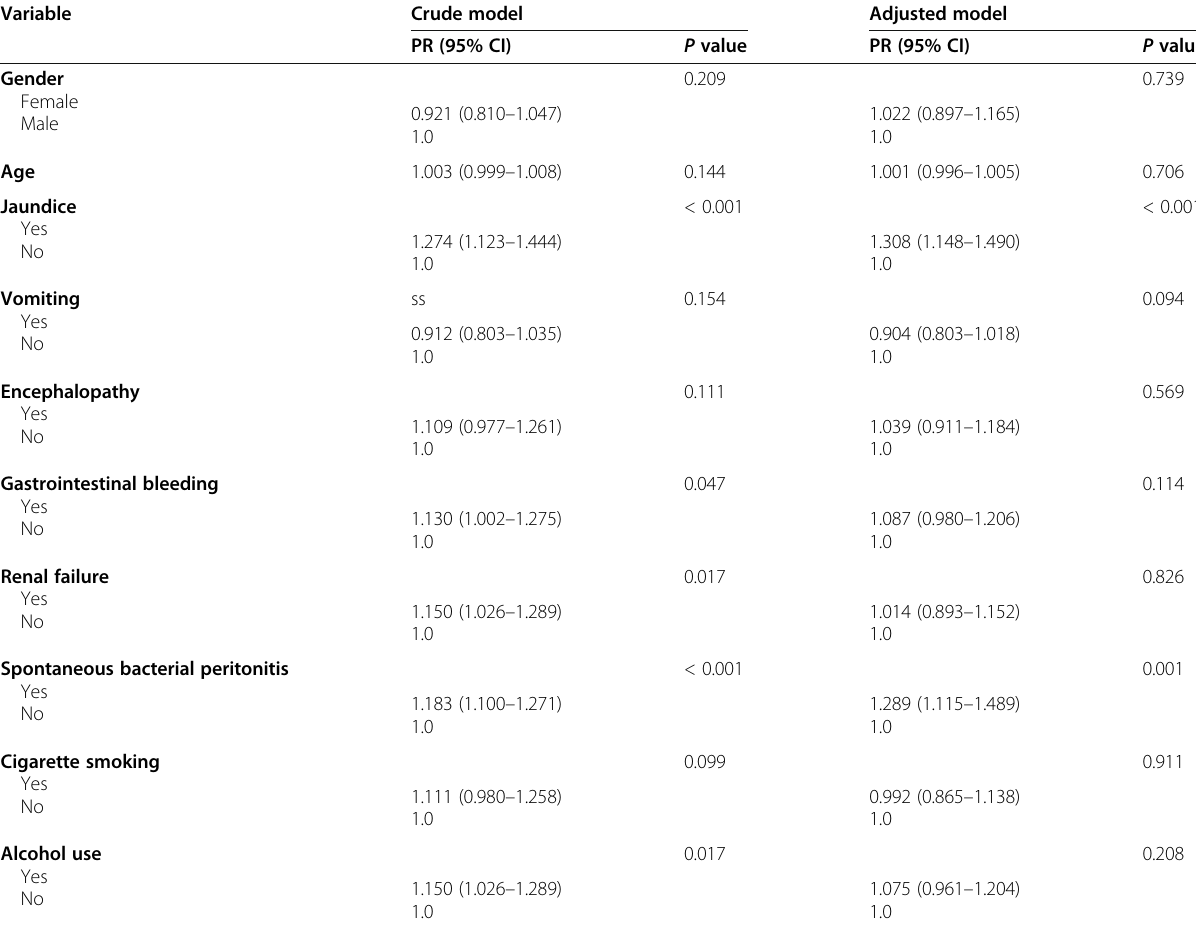
Table 4 Robust Poisson regression models estimating prevalence ratio (PR) and 95% confidence interval (CI) to evaluate the association of various independent variables on the types of Budd – Chiari syndrome